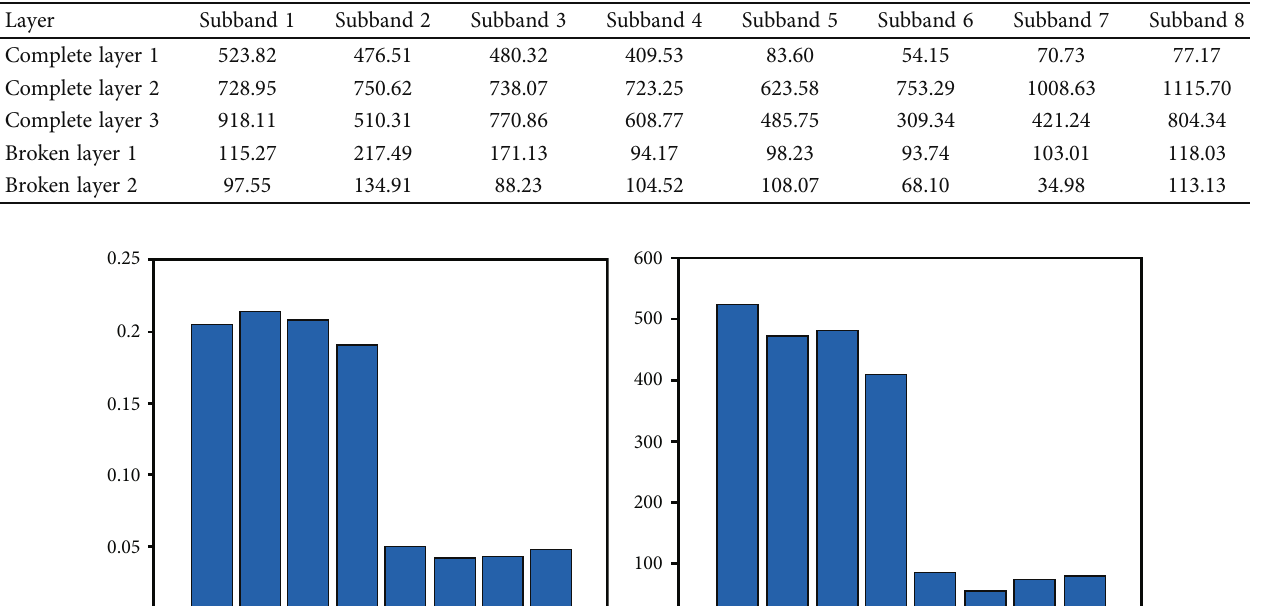
Table 2: Wavelet feature-scale entropy of borehole